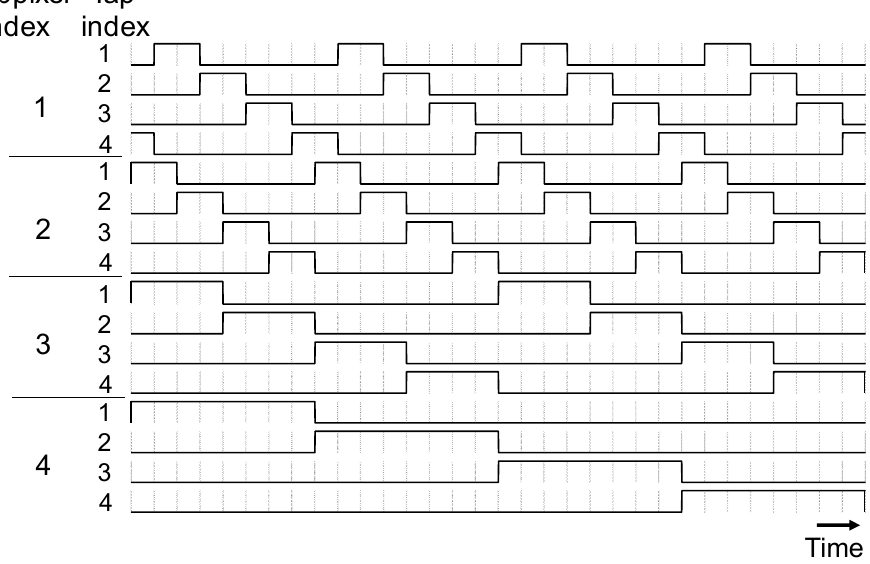
Figure 5. Temporally coded shutters (shutter length of 32 bits) with multiple frequencies and sub- clock shifting. The shutters of subpixel 1 are a half-clock-shifted version of those of subpixel 2.